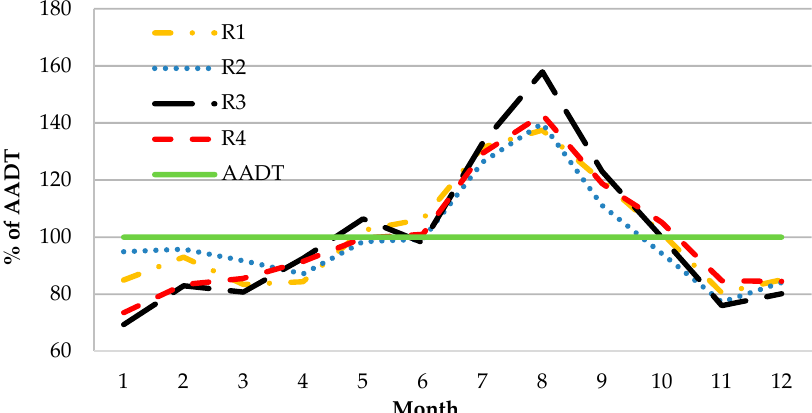
TTIS.00.511.52 Figure 4. SPF diagram for different intersection types. Figure 5. Impact of tra ffi c volume on speed for various sections of the TTIS. Figure 5. Impact of traffic volume on speed for various sections of the Figure 5. Impact of traffic volume on speed for various sections of the TTIS. Figure 6. Variability of traffic volume during the year based on data from the TTIS. Figure 6. Variability of tra ffi c volume during the year based on data from the